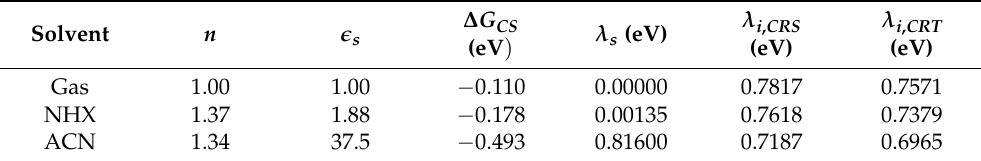
Table 8. The Gibbs free energy change for charge separation, the solvent ( λ s ) and internal reor- ganization energies ( λ i , ) , as well as the solvent properties ( n and (cid:101) s ). The internal reorganization energies calculated using the four-point method with the TZ2P basis and the CAMY-B3LYP functional. CRS = charge recombination to the singlet ground state, CRT = charge recombination to the triplet state, CS = charge